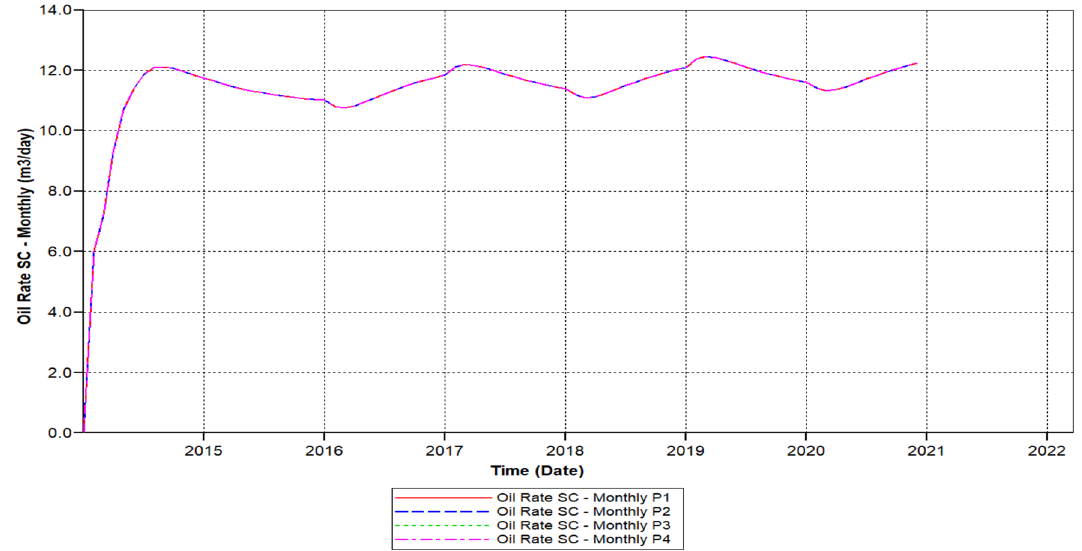
Figure 22. Shows the polymer sand plug model oil ratio CMG STARS 2017.10 URL: https:// www. cmgl. ca/.